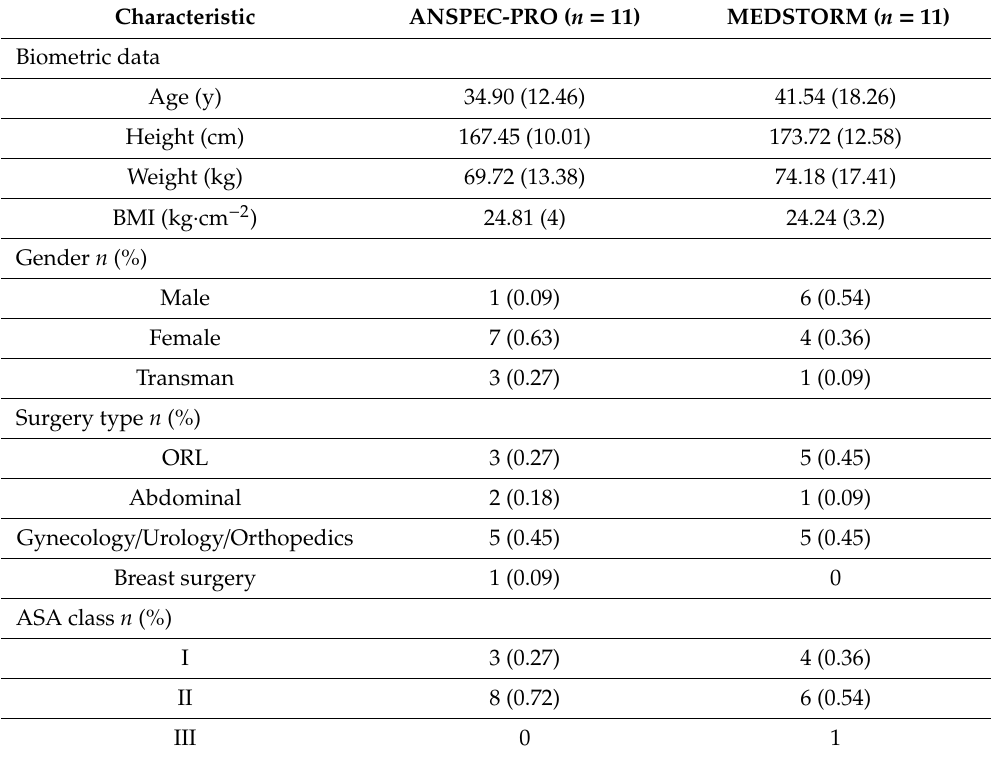
Table 1. Patients characteristics and clinical